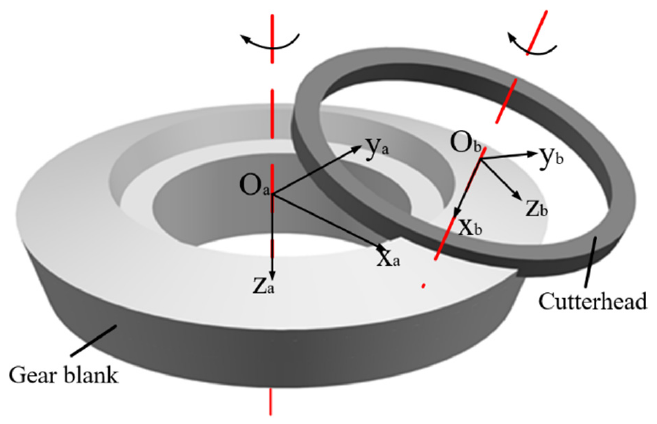
Figure 2. Establishment of the motion relationship model.